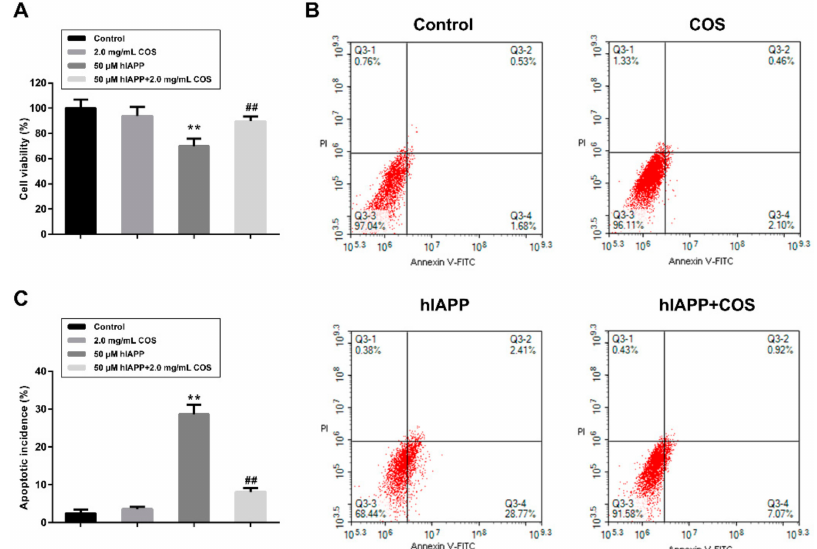
Figure 6. E ff ect of COS on hIAPP induced cytotoxicity to β -TC-6 cells. ( A ) Lactate dehydrogenase release analysis. Cells were treated with 50 µ M hIAPP alone or co-treated with 2.0 mg / mL of COS for 24 h. ( B ) Representative graphs obtained by flow cytometry using double staining with Annexin V-FITC (a marker for apoptosis) and PI (a marker for necrosis). ( C ) The apoptotic incidence of β -TC-6 cells exposed to 50 µ M hIAPP in the presence or absence of 2.0 mg / mL COS for 24 h. Data are expressed as means ± SD of three independent experiments. ** p < 0.01 vs. Control, ## p < 0.01 vs. hIAPP